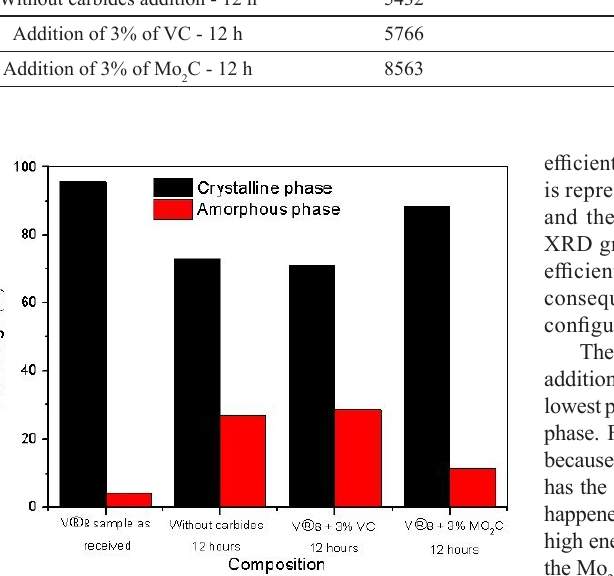
Figure 15: Percentage of crystallinity of the Vanadis ® 8 after 12 hours of